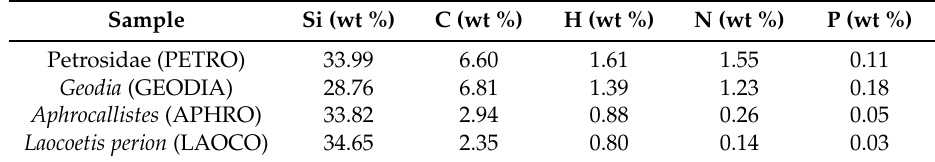
Figure 2. X-ray diffraction (XRD) patterns of the four samples. Main diffraction peaks were attributed to quartz (Q), calcite (C), aragonite (A) and halite (H). Table 1. Si, C, H, N and P content (wt %) of the four samples as obtained by elemental